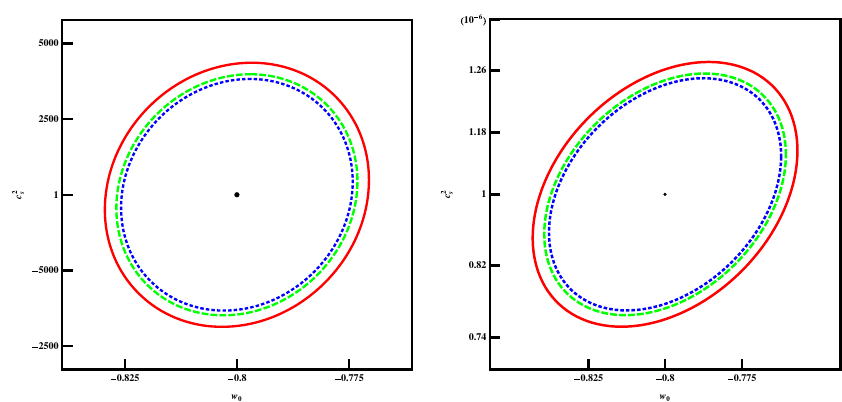
Fig. 29 Confidence region at 68% for three different values of z max = 2 . 5 , 3 . 5 , 4, red solid, green long- dashed and blue dashed contour, respectively. The left panel shows the confidence region when the sound speed is c 2 s = 1; the right panel with the sound speed c 2 s = 10 − 6 . The equation of state parameter is for both cases w 0 = − 0 .